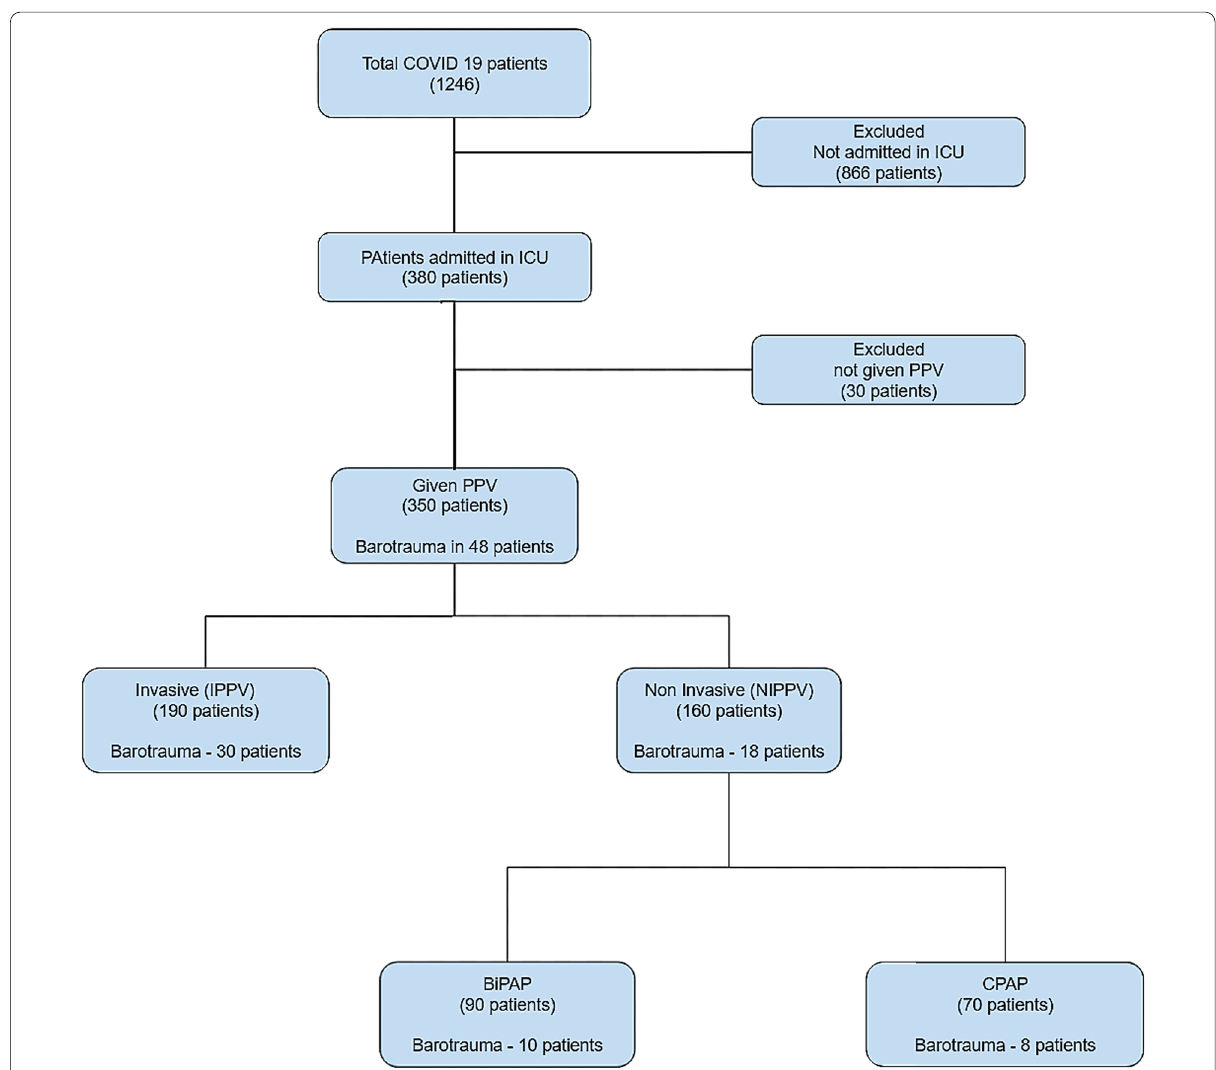
Fig. 1 Distribution of patients admitted in our hospital from March to June 2021